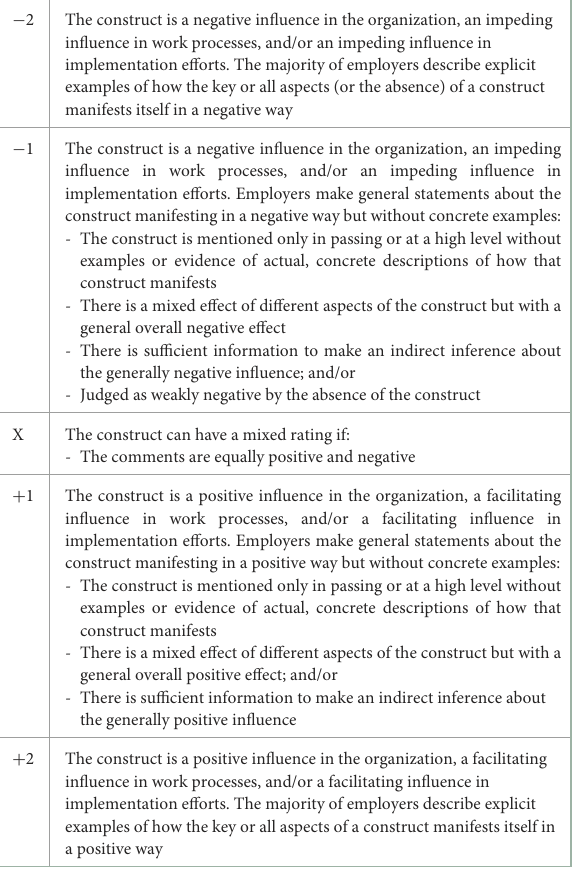
the CFIR framework (20). −